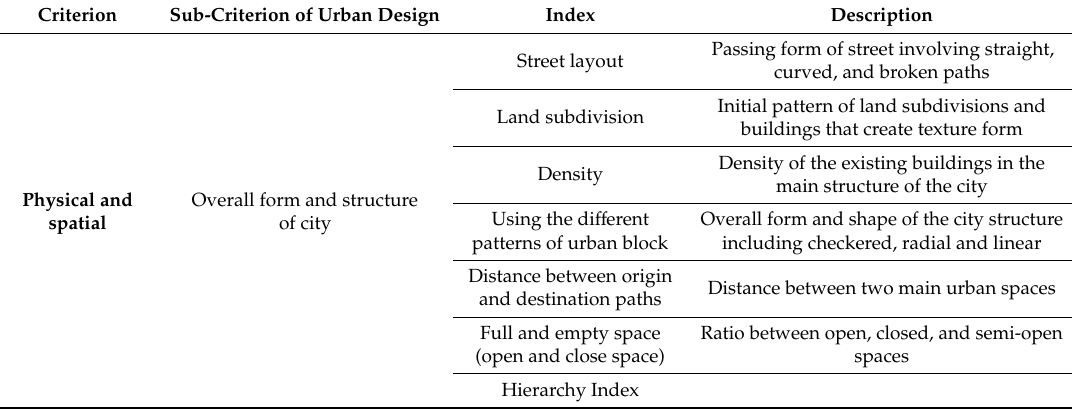
Table2. Criterionandsub-criterionofurbanmorphologydesigna ff